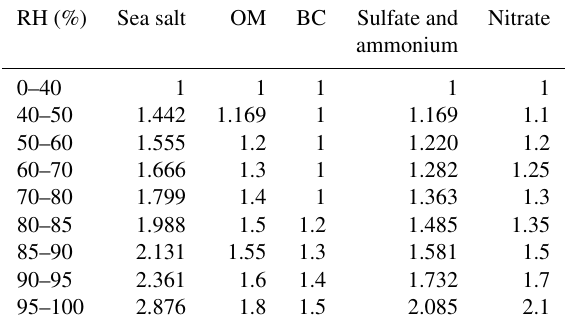
Table 8. Dry deposition velocities in the R05 scheme (cms − 1 ). Species Values over Values over